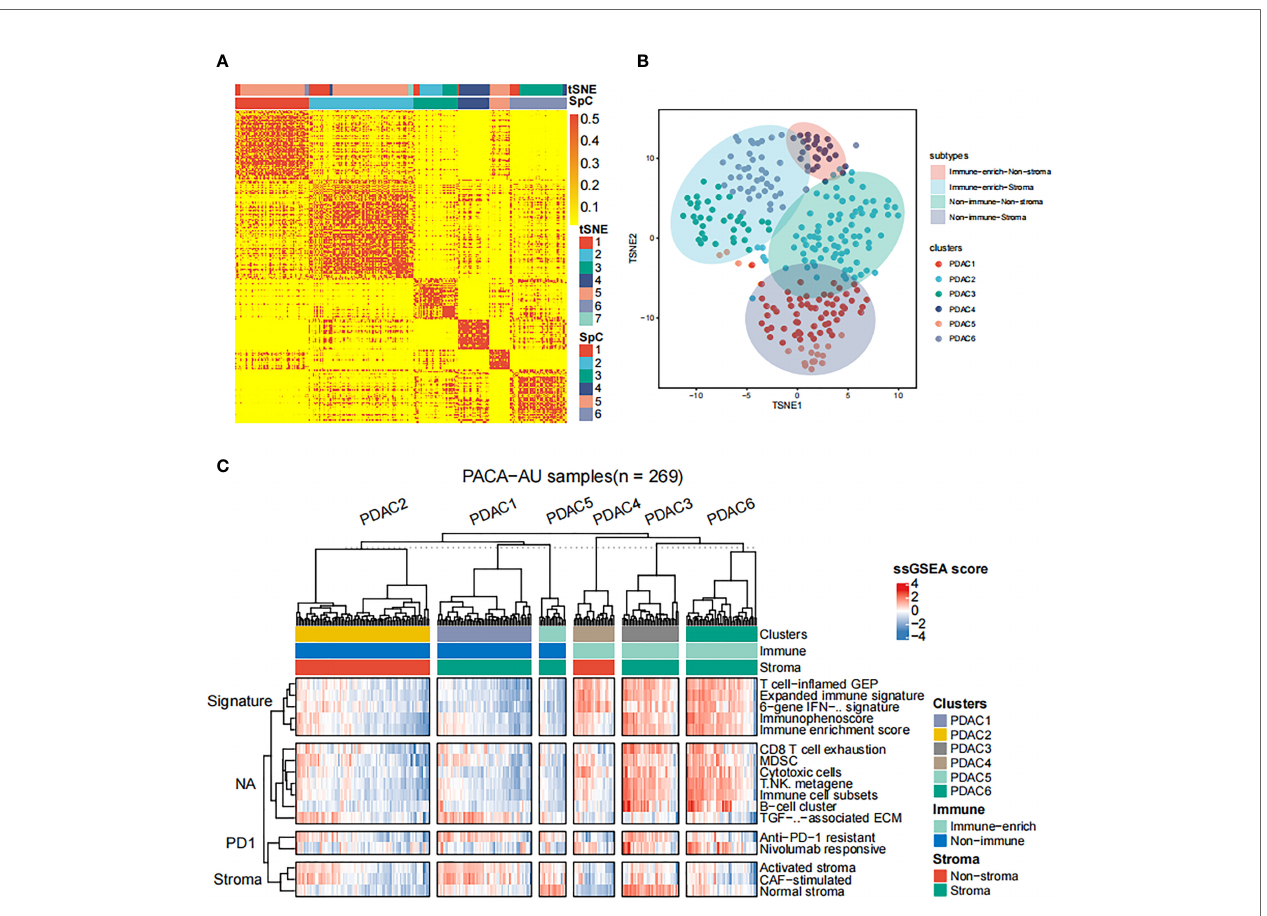
FIGURE 1 | Classi fi cation of distinct tumor microenvironment subtypes (A) Spectral classi fi cation of tumor microenvironment in PACA-AU alignment. This plot shows a heat map of the ssGSEA score, estimated using the gene set from the ICGC database. Based on tSNE cluster analysis, 7 subgroups were obtained, namely PDAC1, PDAC2, PDAC3, PDAC4, PDAC5, PDAC6, PDAC7. Based on Spectral classi fi cation, 6 subgroups were obtained, namely PDAC1, PDAC2, PDAC3, PDAC4, PDAC5, PDAC6. (B) tSNE classi fi cation of tumor microenvironment in PACA-AU cohort. (C) This fi gure shows the 4 immune subtypes of the PACA-AU cohort based on ssGSEA analysis and the main signatures of each